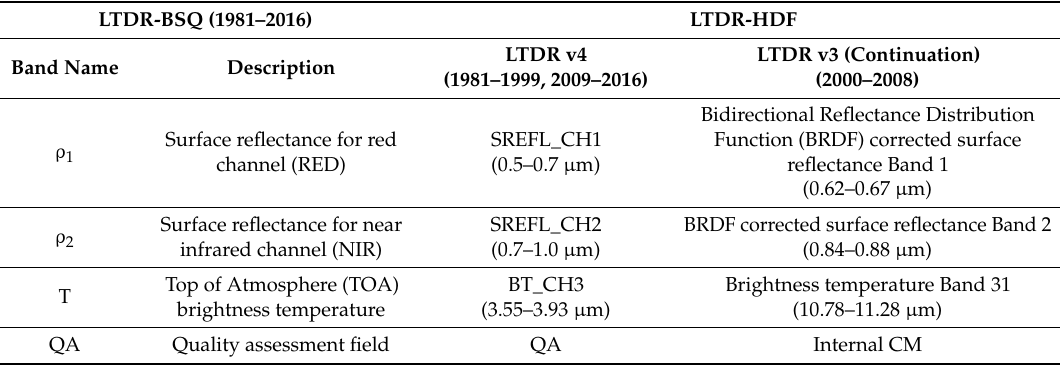
Table 1. Long-Term Data Record (LTDR)-binary sequential (BSQ) and their respective bands from the original LTDR-hierarchical data format (HDF)